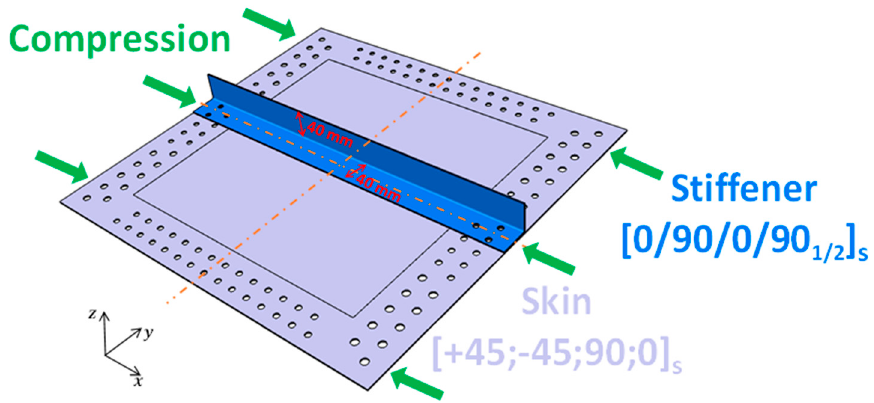
Figure 4. CAD model of the stiffened sample considered: L-stiffener in blue and skin in